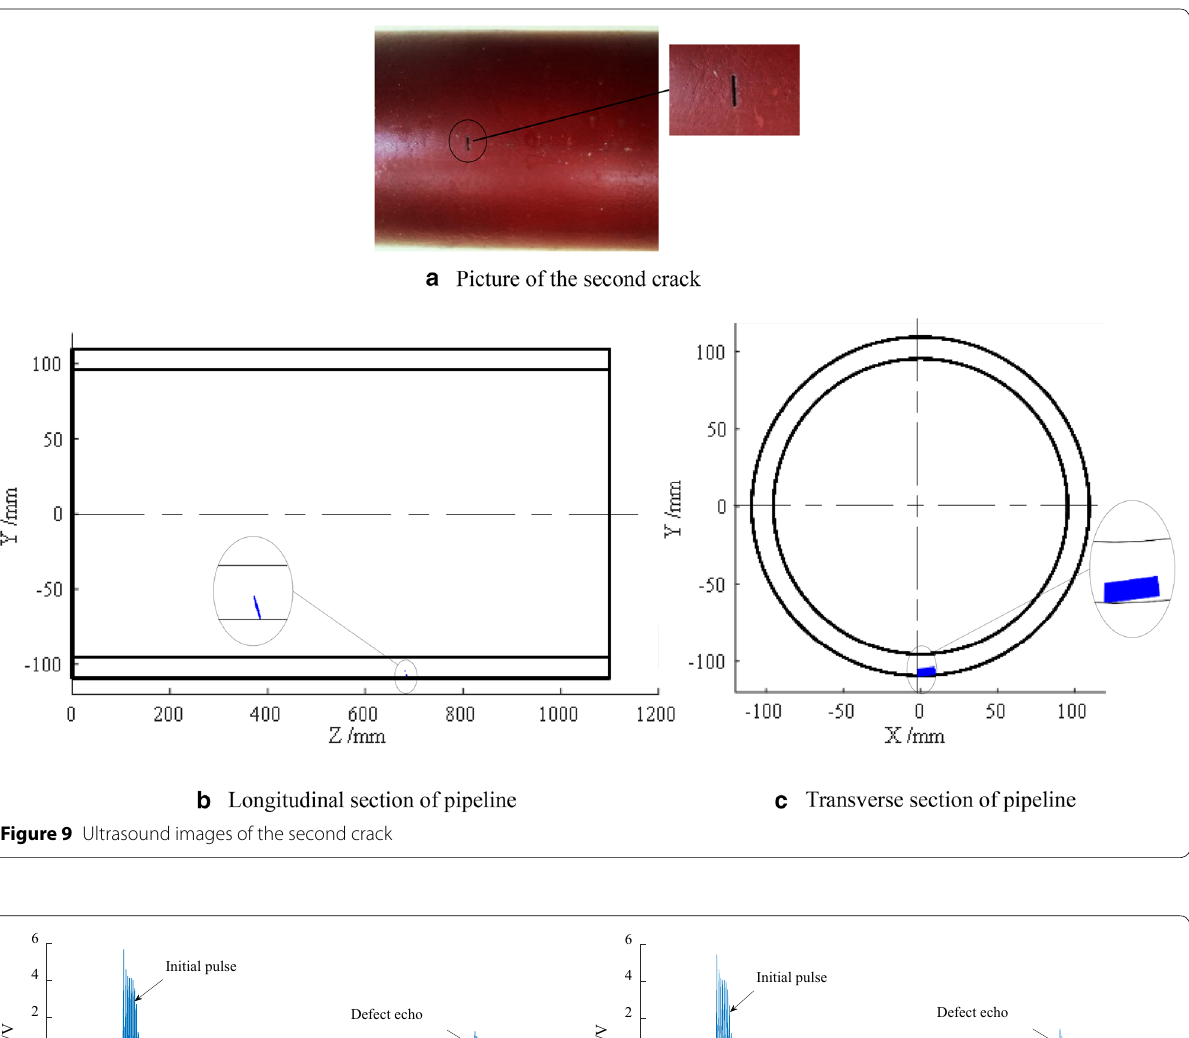
Figure 9 Ultrasound images of the second crack